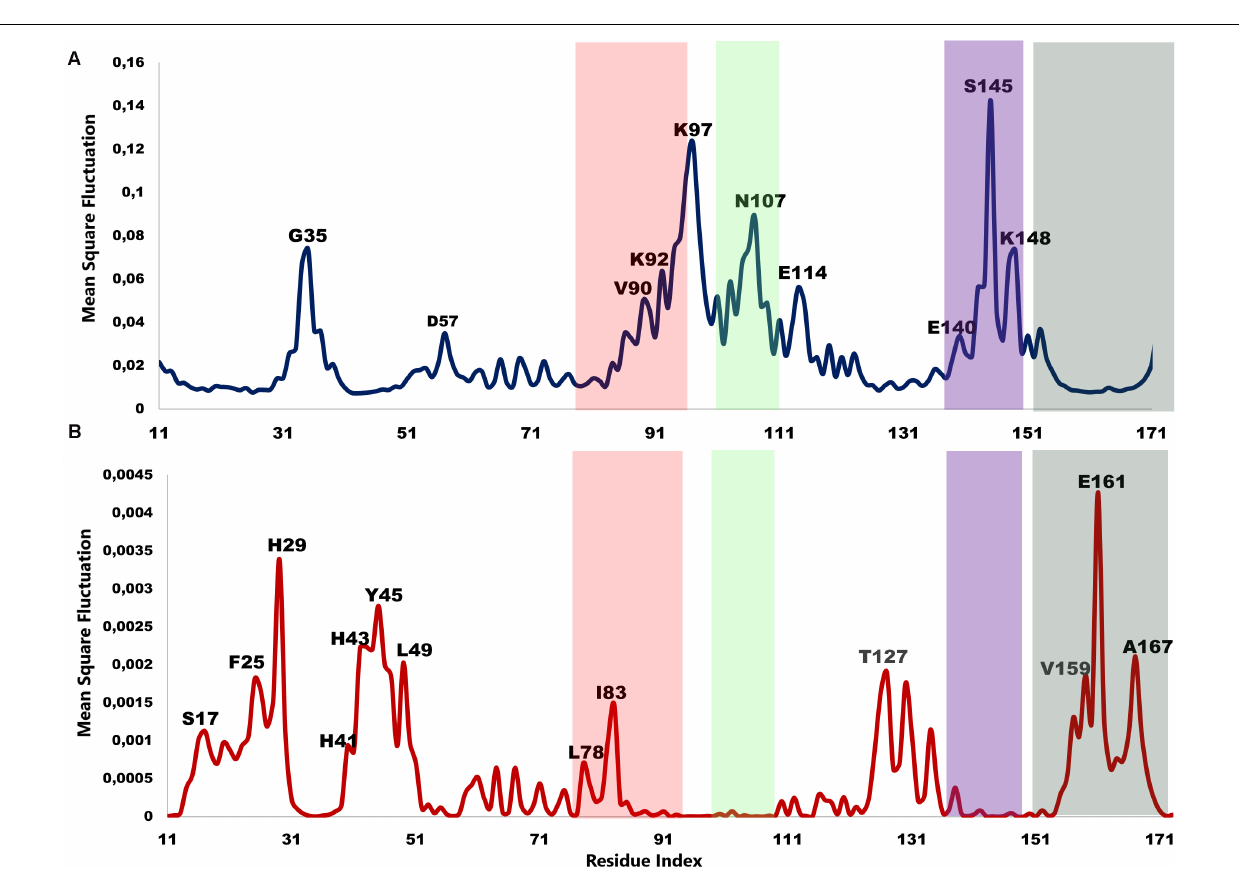
FIGURE 9 | MSF profiles of (A) Low-frequency and (B) High-frequency normal modes. Residues with the highest fluctuations of the slowest modes and the fastest modes are labeled. The dark green, purple, red, and lime green bars highlight the location of motif 5, 6, 7, and 8 respectively. N107 is located in motif 7 (position 9), S145 in motif 8 (position 10), L78, and I83 are located in motif 6 (position 3 and 8) and V159, E161, and A167 are located in motif 5 (position 6, 8, and 14)